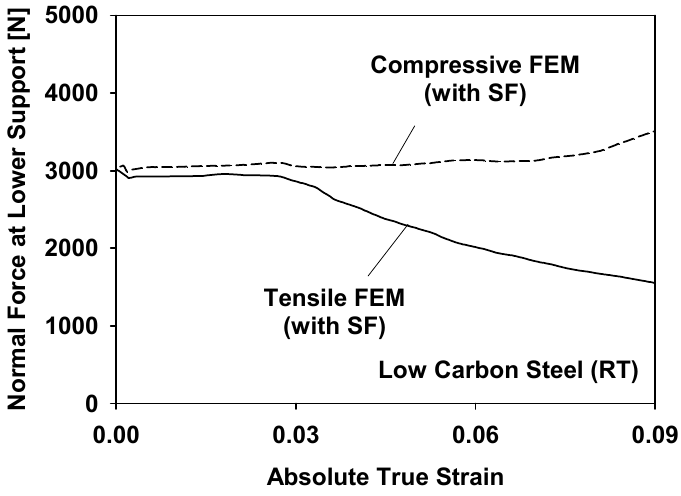
Figure 12. Comparison of the forces acting on the lower anti ‐ buckling bar during tension and com ‐ pression.